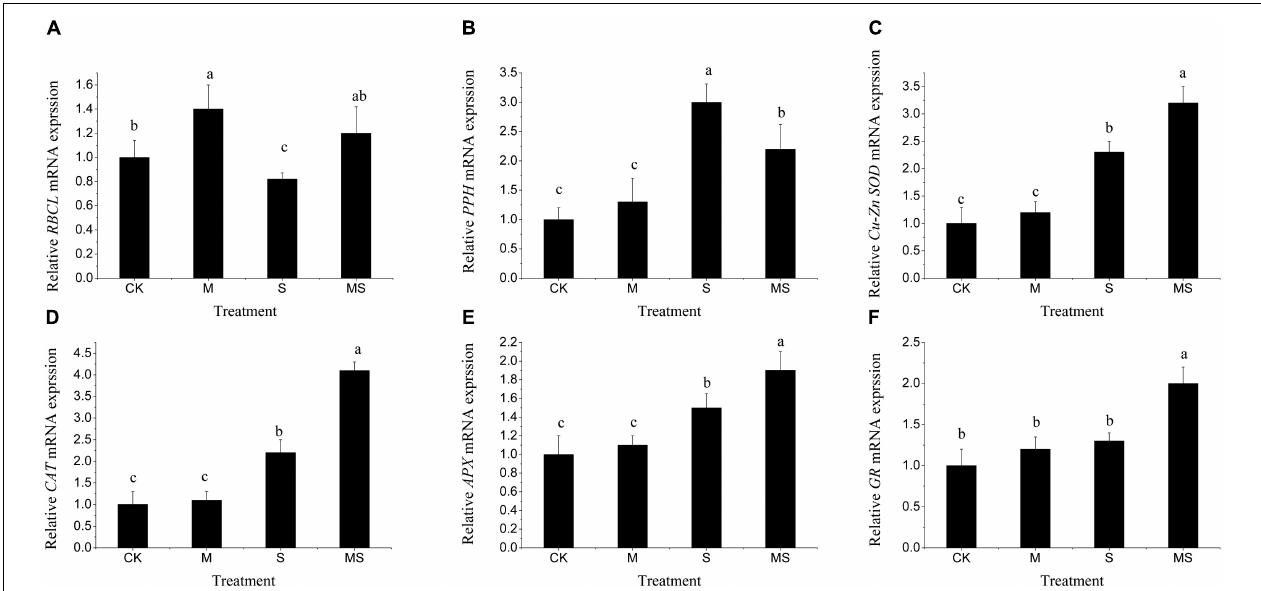
FIGURE 6 | Relative expression patters of the RBCL (A) , PPH (B) , Cu-Zn SOD (C) , CAT (D) , APX (E) , and GR (F) genes in watermelon inoculated or non-inoculated seedlings with AMF Funneliformis mosseae and subjected or not to salinity-alkalinity stress. Values are means ± standard errors ( n = 3). Bars with different letters are significantly different at the 0.05 level (Duncan’s multiple range test). RBCL , rubisco large subunit; PPH , pheophytin pheophorbide hydrolase; Cu-Zn SOD , Cu-Zn subunit-superoxide dismutase; CAT , Catalase; APX , cytoplasmic ascorbate peroxidase; GR , cytoplasmic glutathione reductase; AMF, arbuscular mycorrhizal